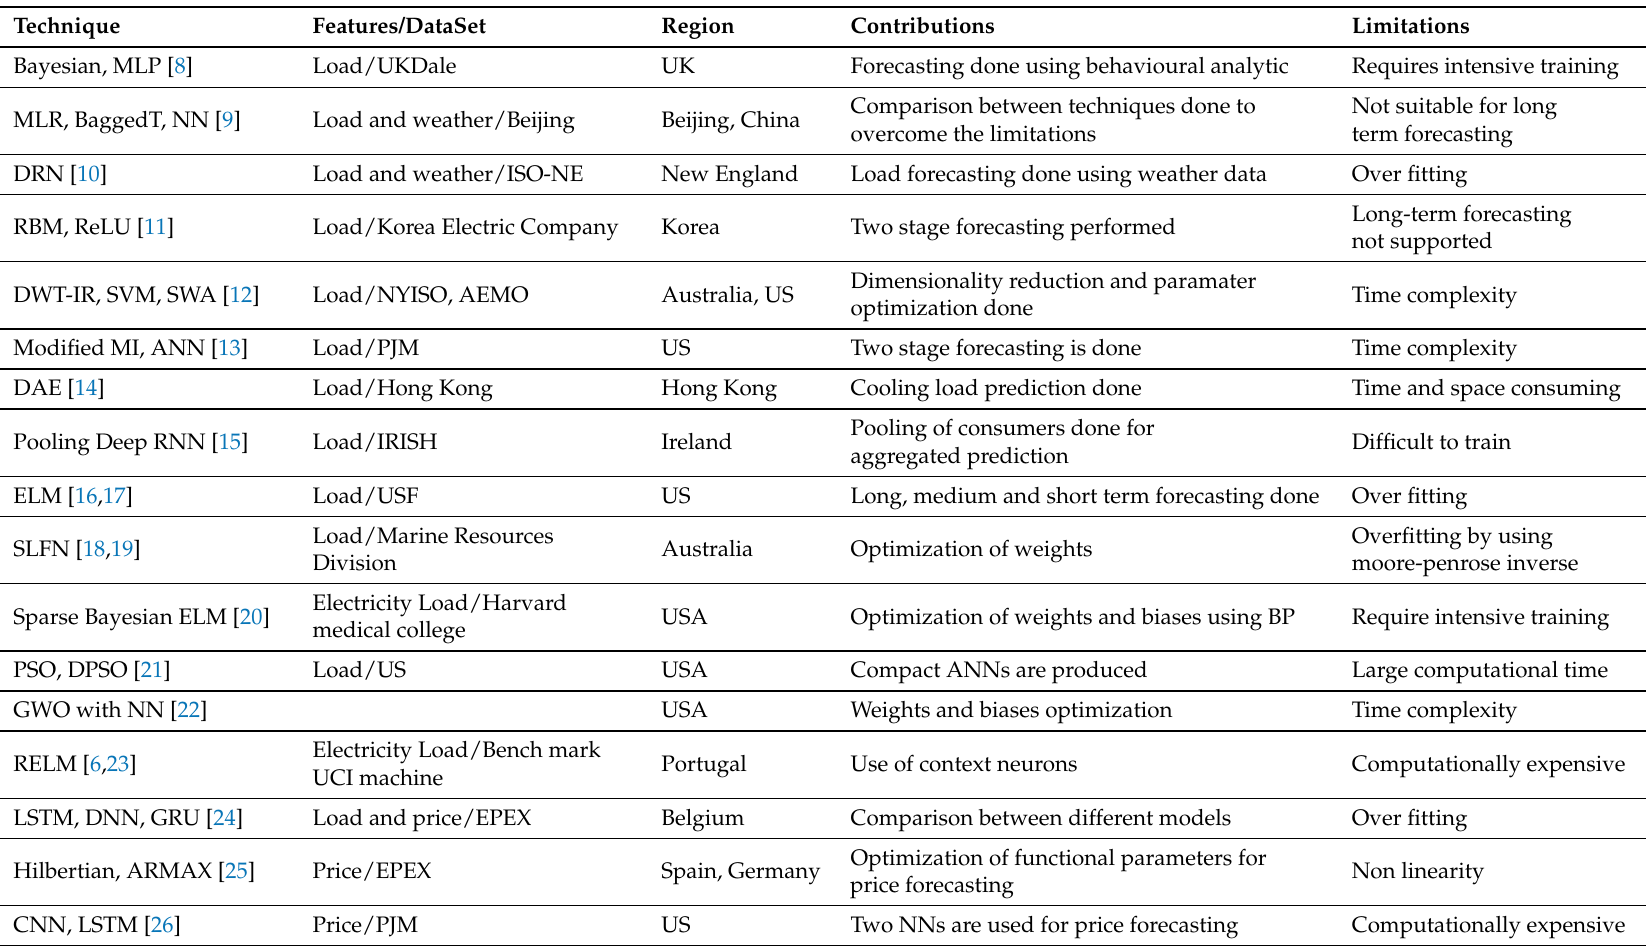
Table 4. Summary of related